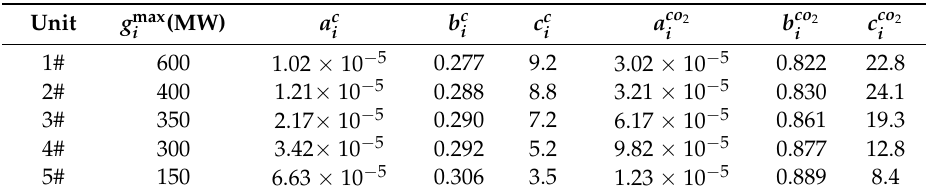
Table 3. Unit emission